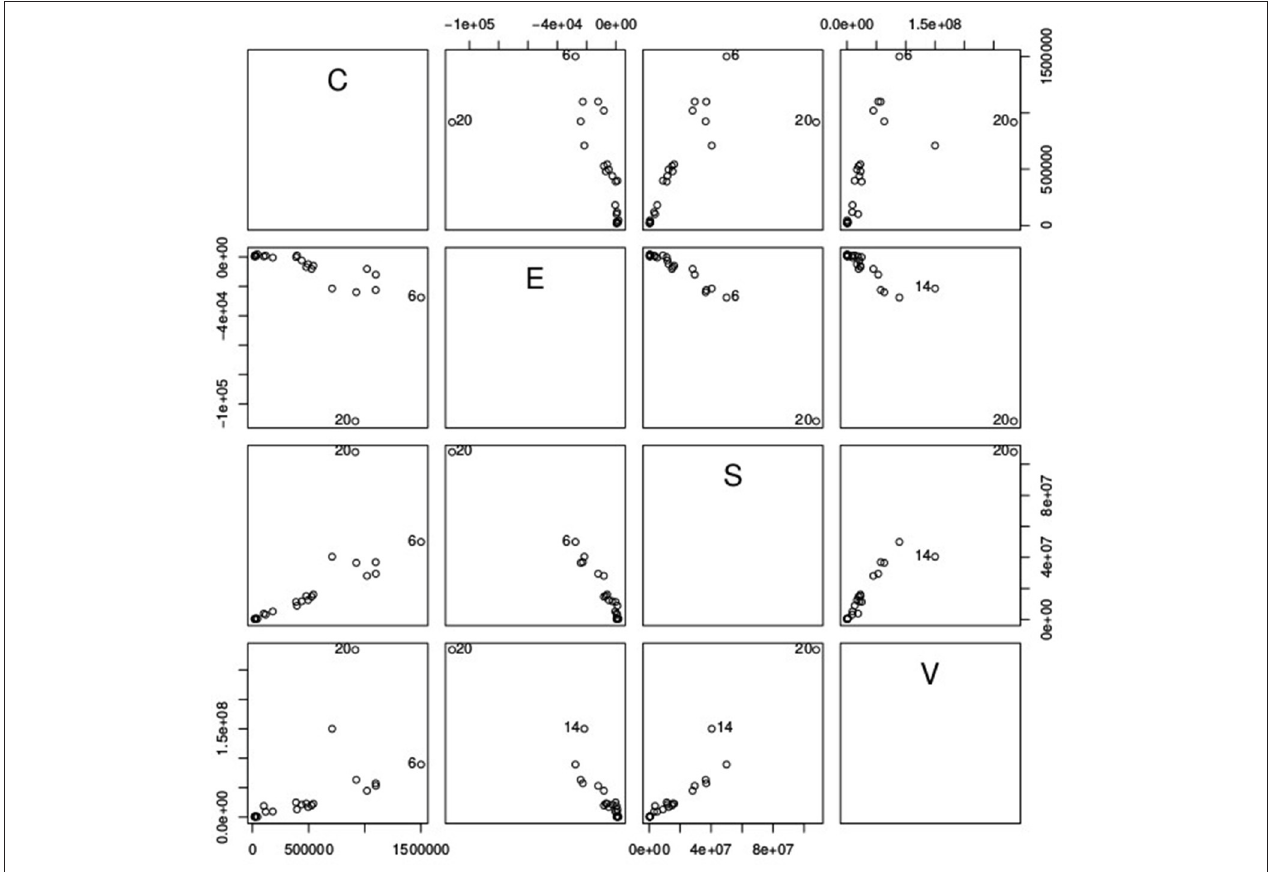
FIGURE 3 | Dispersion graphs matrix.